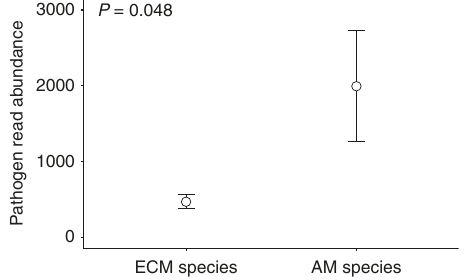
Fig. 5 Abundances of pathogenic fungi associated with ECM and AM seedling roots. Values represent mean read numbers of pathogenic OTUs associated with fi ne roots of fi eld seedlings, and error bars represent standard errors ( n = 30 biologically independent fi ne root samples). P = 0.048 based on independent two-sample t -test. Source data are provided in a Source data fi